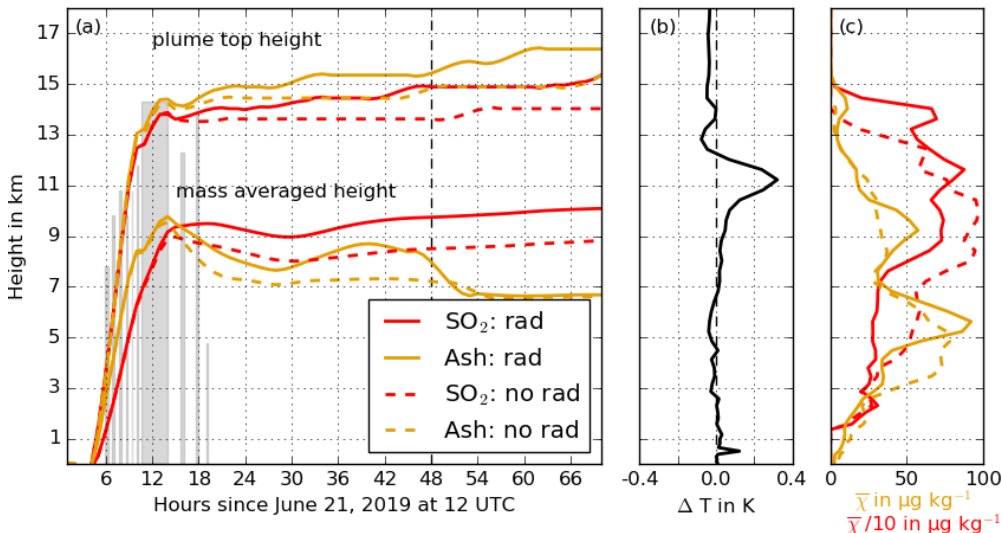
Figure 6. (a) Temporal evolution of the SO 2 (red) and ash (yellow) plume top height and mass-averaged height for the FPlume-rad (solid) and FPlume-norad (dashed) experiment smoothed by a Savitzky–Golay filter. The gray bars indicate the duration and height of the 10 individual eruption phases. They are based on the analysis of the GOES-17 data, which serve as inputs for FPlume. (b) Vertical profile of the temperature difference between FPlume-rad and FPlume-norad in the ash plume 48h after the start of the simulation. (c) Vertical SO 2 (red) and ash (yellow) profile after 48h for the FPlume-rad (solid) and FPlume-norad (dashed) experiment.